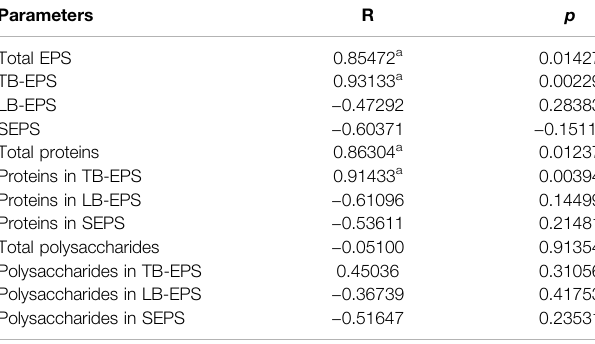
TABLE 3 | Pearson correlation coef fi cients between CST and EPS components.